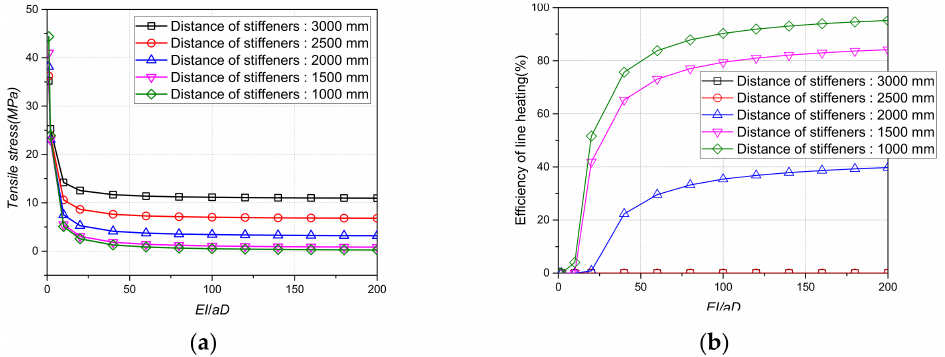
Figure 14. Tensile stress and line heating efficiency by stiffness ratio of plate and beam according to distance of stiffeners. ( a )Tensile stress by thickness of the plate; ( b ) Line heating efficiency by distance of plates.